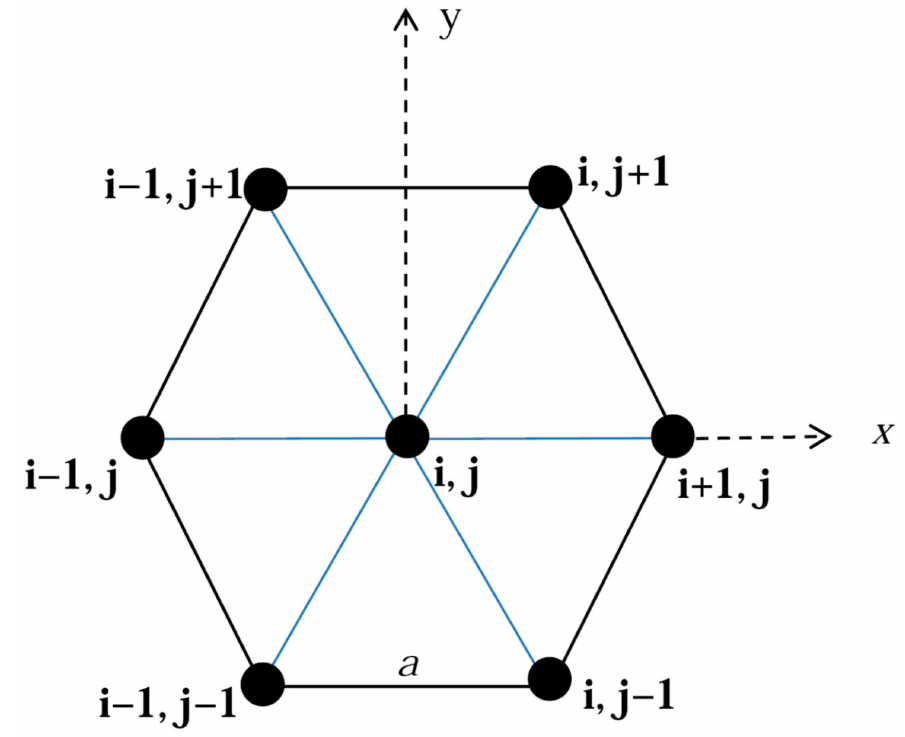
Figure 2. Hexagonal lattice sites (solid circles) on the (0001) slip plane of HCP CSAs. The lattice constant is a , and i and j are integers labeling the sites.